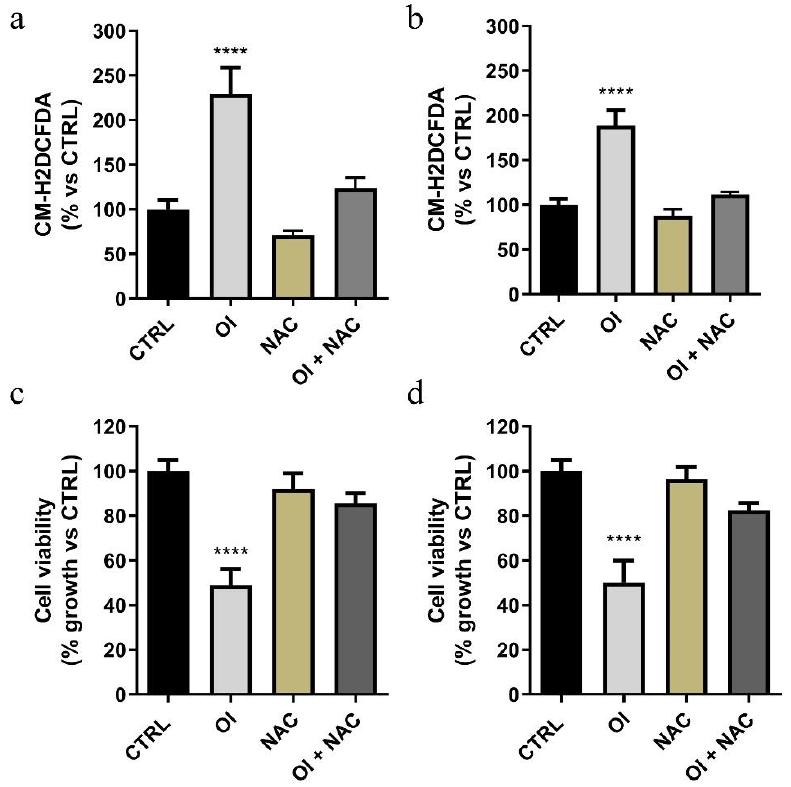
Figure 5. The compound OI causes a significant increase in ROS levels. Both MCF-7 ( a ) and HeLa ( b ) cells were treated for 24 h with 15 and 30 µM OI , respectively, alone and/or in the presence of N-acetyl-l-cysteine (NAC); ROS levels were evaluated by FACS analysis using the CM-H2DCFDA probe. Cell proliferation assay (MTT assay) was performed in both treated MCF-7 ( c ) and HeLa ( d ) cells, in the presence or absence of 3 mM NAC. Note that after 72 h, in the presence of NAC, cells displayed recovery in growth. Values represent means ± SD of three different experiments, each performed with triplicate samples. * p value < 0.05; **** p value < 0.0001.